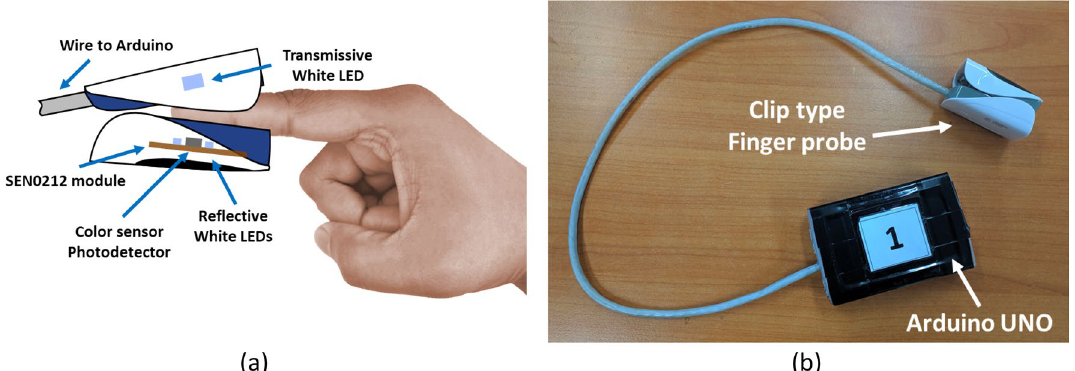
Figure 6. Illustration of ( a ) sensor module-LED arrangement and ( b ) physical image of the